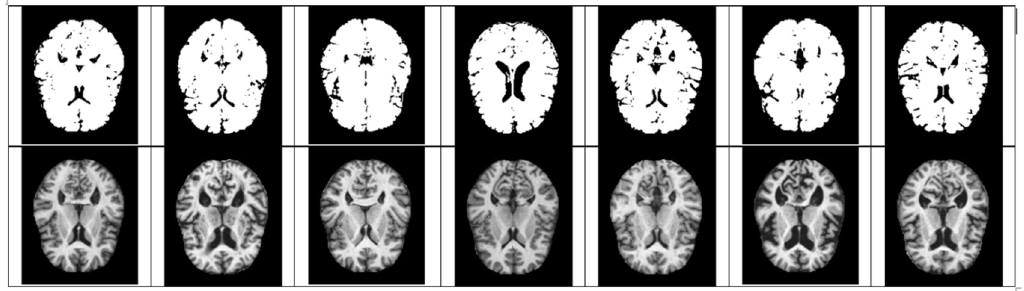
Figure 5. Quantized moderate examples ( above ), original very mild examples ( below ).